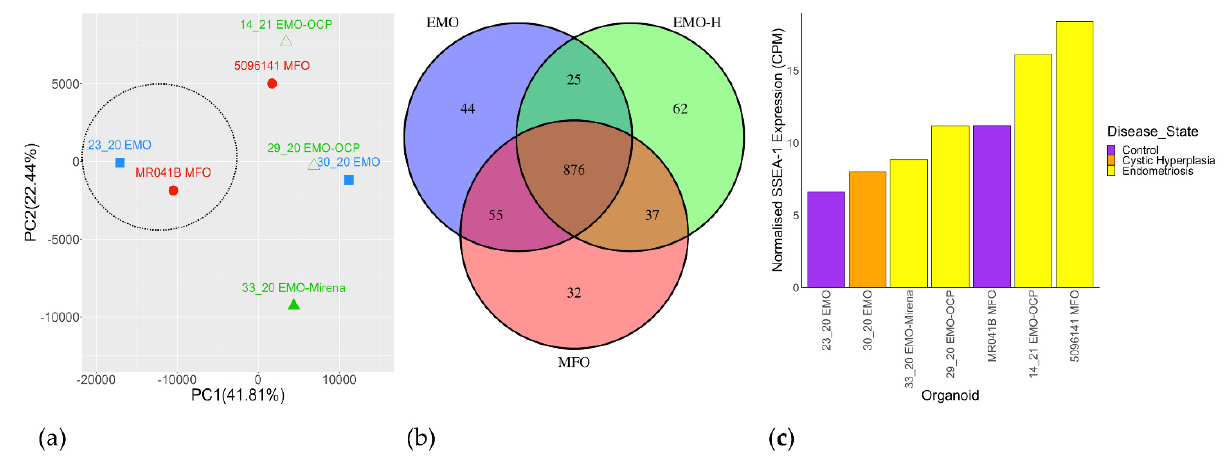
Figure 4. Gene expression profile of MFO, EMO-H, and EMO determined by RNAseq. PCA plot ( a ) of top 1000 genes expressed by MFO, EMO − H, and EMO. MFO (red), EMO (blue), and EMO − H (green) did not cluster separately. Controls (dotted) clustered separately on PC1 only. Venn diagram ( b ) showing the majority of the top 1000 expressed genes were shared by MFO, EMO-H, and EMO. Normalised SSEA-1 expression ( c ) was increased in two of the four women with endometriosis.